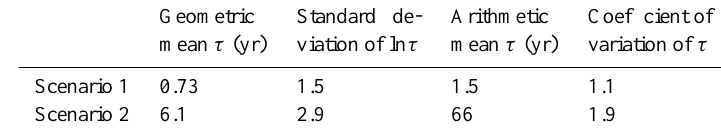
Table 1. Statistics of advective solute travel time τ to nearest surface water for the two K variability scenarios in Fig. 1.